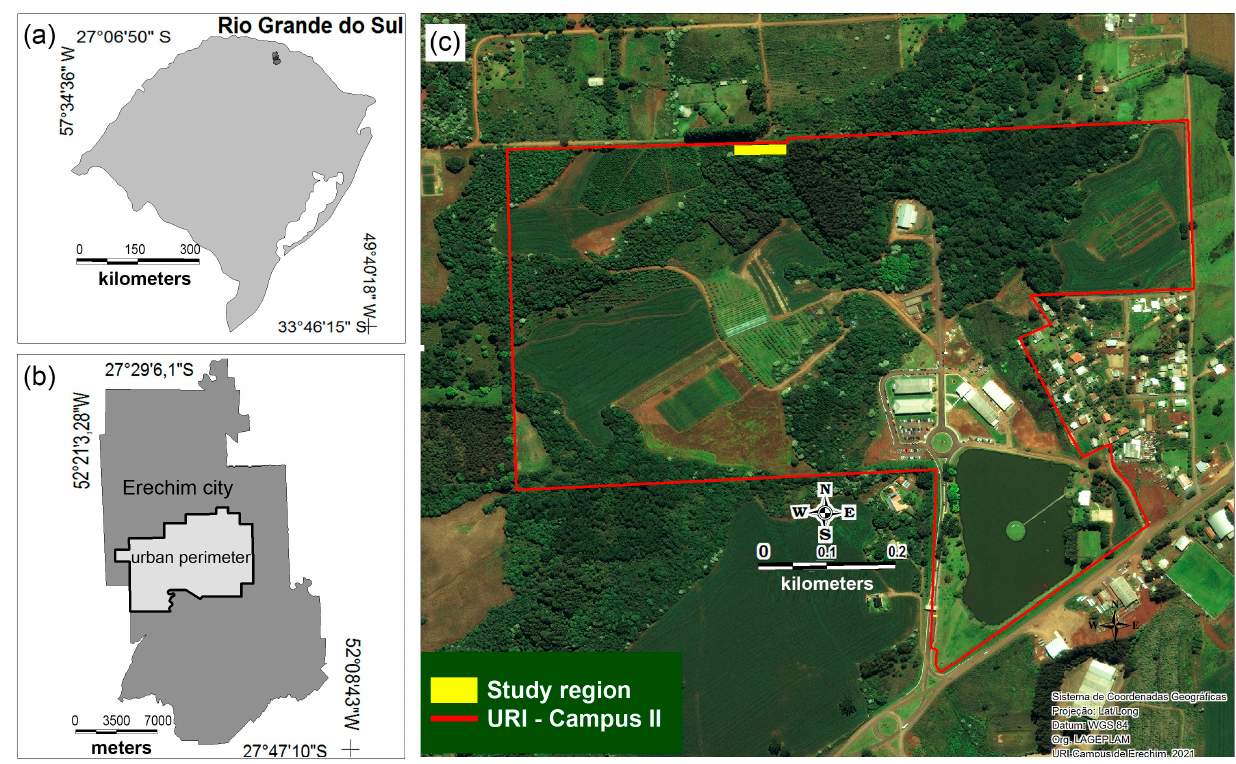
Figure 1. Geographic localization and design of the experiment. In ( a ) is the Rio Grande do Sul map (Brazil South); in ( b ) is the Erechim city map; and in ( c ) is the study